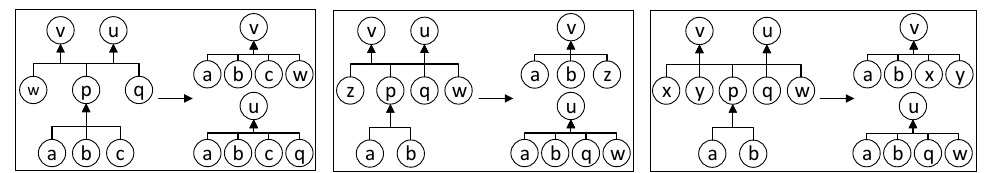
Figure 4: The cases that the out ( p ) is